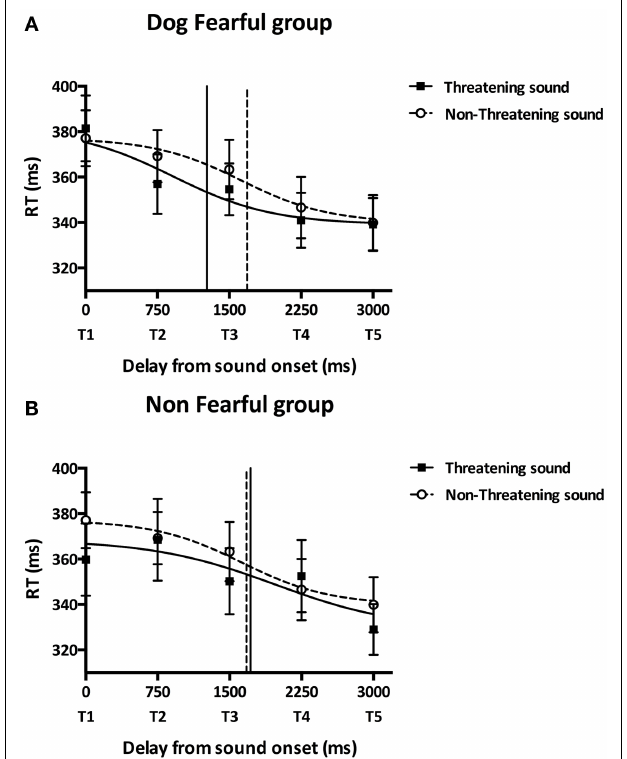
FIGURE 3 | Main experiment results . Participants performed the audiotactile task by responding to a tactile stimulation while a task-irrelevant threatening (dog growling) or non-threatening (sheep bleating) sound was looming toward them.This figure reports the mean tactile reactions times ( ± SEM) for the dog-fearful (top graph) and non-fearful group (bottom graph) in the threatening (black square) or non-threatening (white circles) sound conditions as a function of the delay of tactile stimulation delivery from sound onset. Reaction times were fitted with a sigmoid function.The inflection point abscissa of the sigmoid curves was computed as a measure of the temporal delay, i.e., the distance, at which sound starts affecting tactile RTs and was analyzed in order to quantify PPS boundaries. (A) Dog-fearful group results.The abscissa of the curve’s inflection point was lower in the threatening sound condition (1266.81 ± 287.57ms, black vertical line) compared to the non-threatening sound condition (1685.49 ± 548.41ms, dashed vertical line) meaning that PPS boundaries were farther from participants in the presence of the dog sound than in the presence of the sheep sound. (B) Non-fearful group results.The abscissa of the curve’s inflection point did not significantly differ between the threatening (1717.70 ± 413.23ms, black vertical line) and the non-threatening (1675.15 ± 596.56ms, dashed vertical line) sound conditions suggesting that participants’ PPS size was similar in the presence of the dog and the sheep sounds.While the dog-fearful group’s PPS was larger than the non-fearful group’s PPS in the presence of the dog sound, there was no significant difference in PPS size between groups in the presence of the sheep